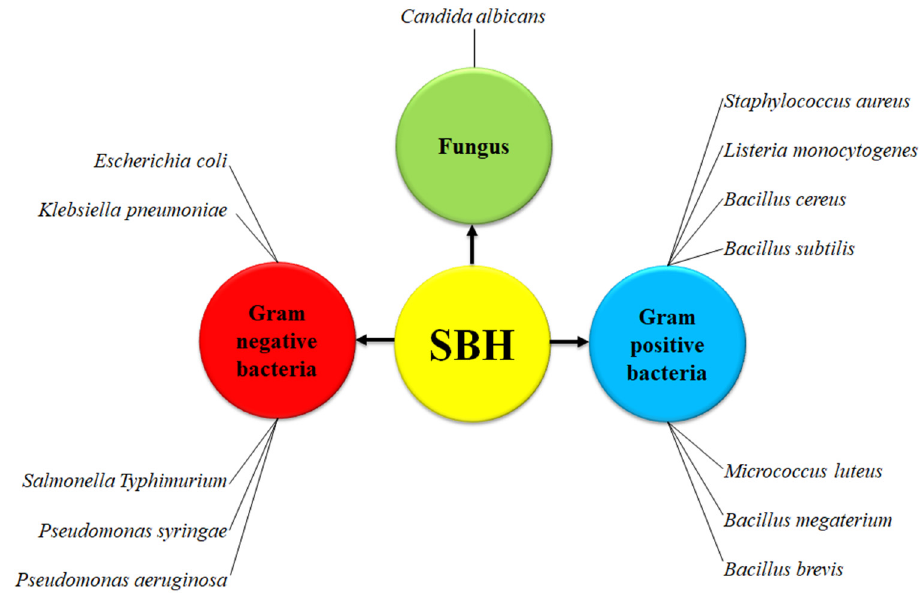
Figure 9. The antimicrobial activities of SBH that have been examined to date.